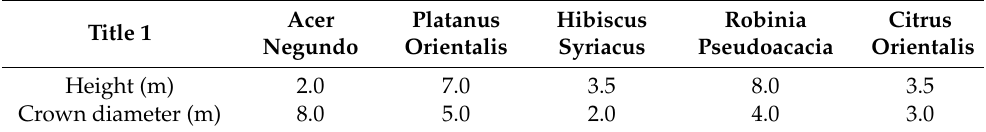
Table 5. Height and crown diameter of the modeled tree